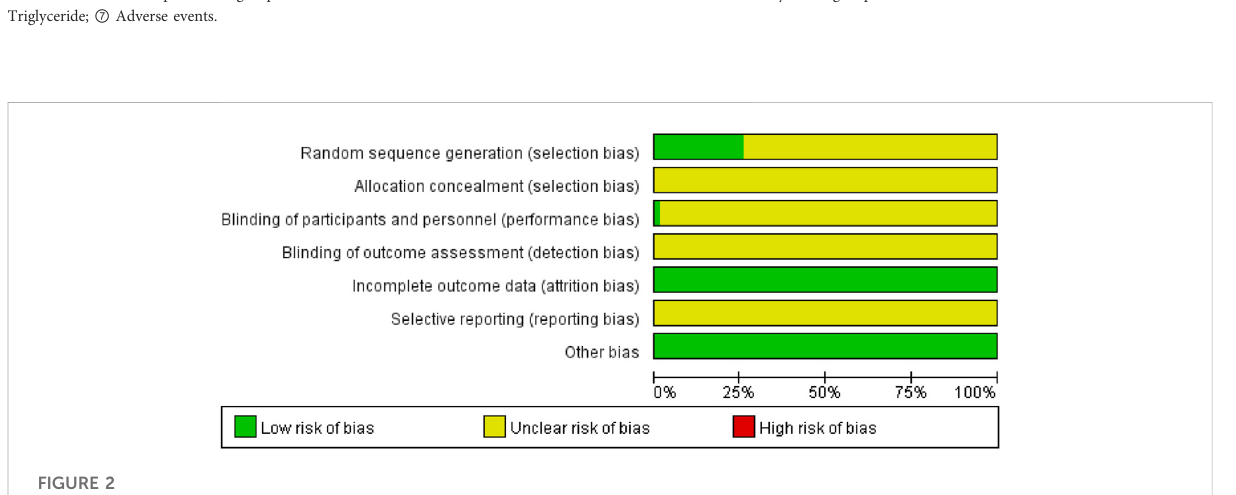
indirect comparisons can be made through reticulated Meta- analysis. The thickness of the line represents the number of included studies comparing each treatment, and the circular area represents the sample size of the population using the measure.